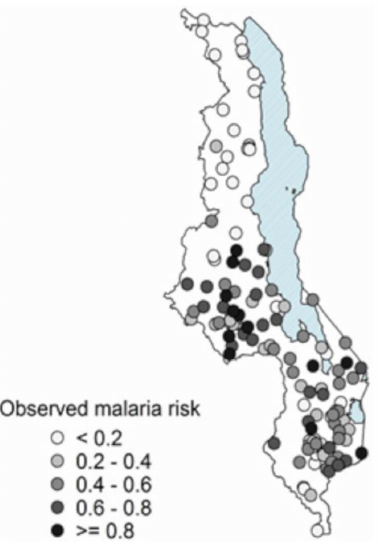
Figure 1. Observed malaria risk in children under five. Observed malaria risk in children under five years at the 140 EAs across